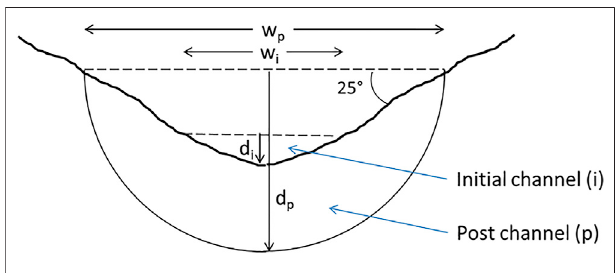
FIGURE 8 | Graphic depicting our geometric model for calculating material excised in the channel on the proglacial